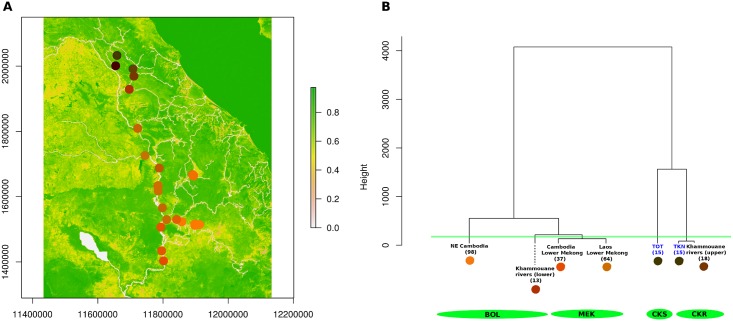
Spatial-genetic structure of Neotricula γ-aperta.A, colour plot of lagged global scores on geographical space; B, dendogram produced by Ward clustering. In part B, sub-population of spring-dwelling snails denoted by blue text, clade sizes (number of individuals) are given in parentheses, and the colours of the spots beneath each clade description correspond to those in the scores plot in A. The green line indicates the taxa combined to form the four sub-populations used in the migration analyses, with the sub-populations themselves shown in the green ellipses below. Underlying map in A based on OpenStreetMap (OpenStreetMap contributors) data, freely available under the Open Database License.